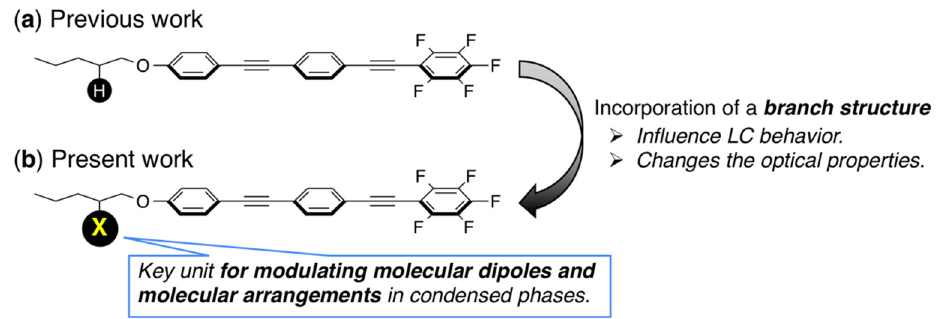
Figure 1. Structures studied in ( a ) a previous study and ( b ) the present work for the development of light-emitting liquid crystal (LELC) molecules. LC: liquid crystal.